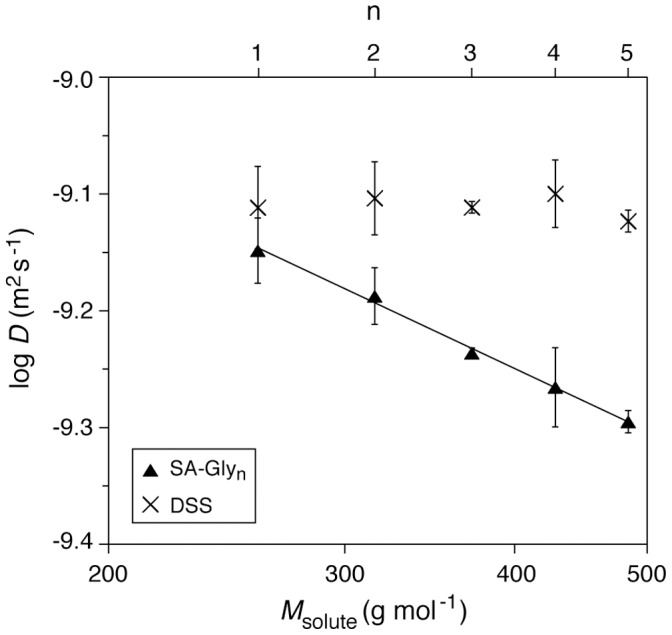
Variation of diffusion coefficient (D) with molecular weight (M
solute) and chain length (n) of SA-Glyn ligands.The constant values of D measured for the internal standard DSS (4,4-dimethyl-4-silapentane-1-sulfonic acid) in the different samples demonstrate the consistency of experimental conditions (e.g., viscosity). Error bars represent standard deviations calculated from the full-width at half maximum of the peaks in DOSY spectra. A linear fit to the SA-Glyn data (log D vs log M
solute) is shown with fitting parameters of −0.54±0.02 (slope) and −7.83±0.05 (y-intercept), yielding an R2 of 0.996.